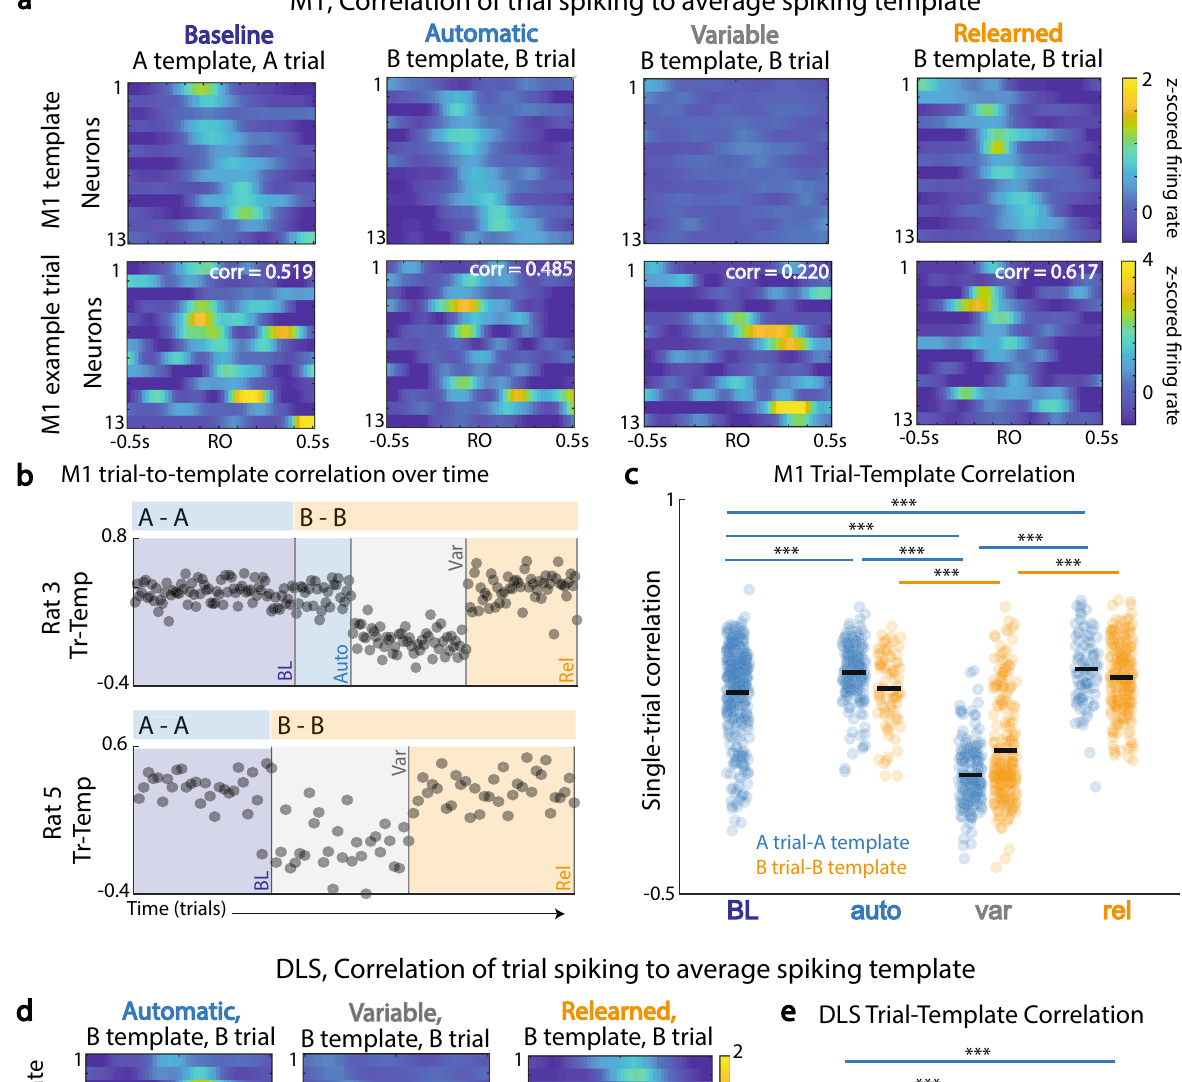
Fig. 3 Changes in M1 and DLS single-trial ensemble reliability. a Top: leave-one-out trial-averaged spiking pattern of M1 units for reach period, − 0.5 s to 0.5 s around fi rst reach onset, across session types. Bottom: left-out trial correlation with session template. b Trial-to-template correlation across trials, with A trial-to-template correlations shown for the baseline session, and B trial-to-template correlations shown for subsequent sessions. Baseline (BL), automatic (auto), variable (var), and relearned (rel). c Comparison of M1 trial-to-template correlations for all trials by session type. d Same as ( a ) for DLS units in example sessions. e DLS trial-to-template correlations for all trials by session type. *<0.05; **<0.01; ***<0.001, linear mixed effects model, Bonferroni-corrected signi fi cance. Source data are provided as a Source Data fi le.